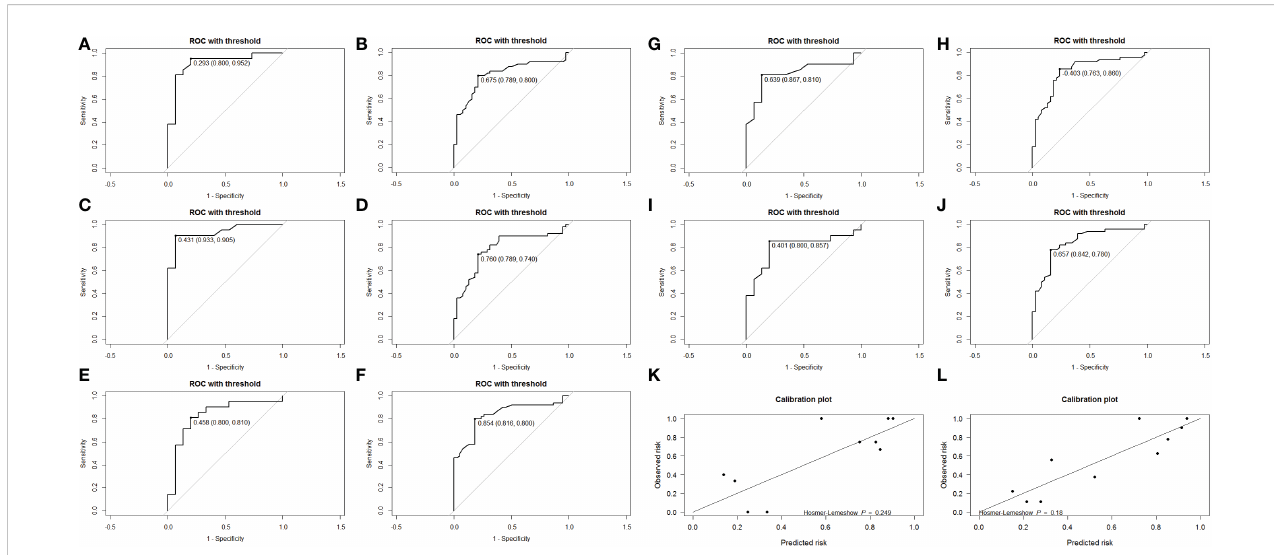
FIGURE 3 Receiver operating characteristic (ROC) curves for the internal validation set (A, C, E, G, I) and the training set (B, D, F, H, J) . Calibration plots for the last internal validation of the model, training set (L) , and validation set (K) .